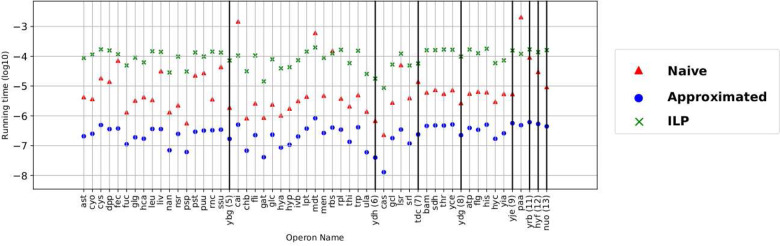

X axis: operon/gene block names, we sort the gene blocks in ascending order according to the number of genes in each block. From left to right: operon ast to operon ygb have 5 genes in the gene block; cai to ydh have 6 genes; cas to tdc have 7 genes; bam to ydg have 8 genes; atp to yje have 9 genes; paa to yrb have 11 genes, hyf has 12 genes. nuo has 13 genes. Y-axis: run time of the method in  log⁡10 seconds